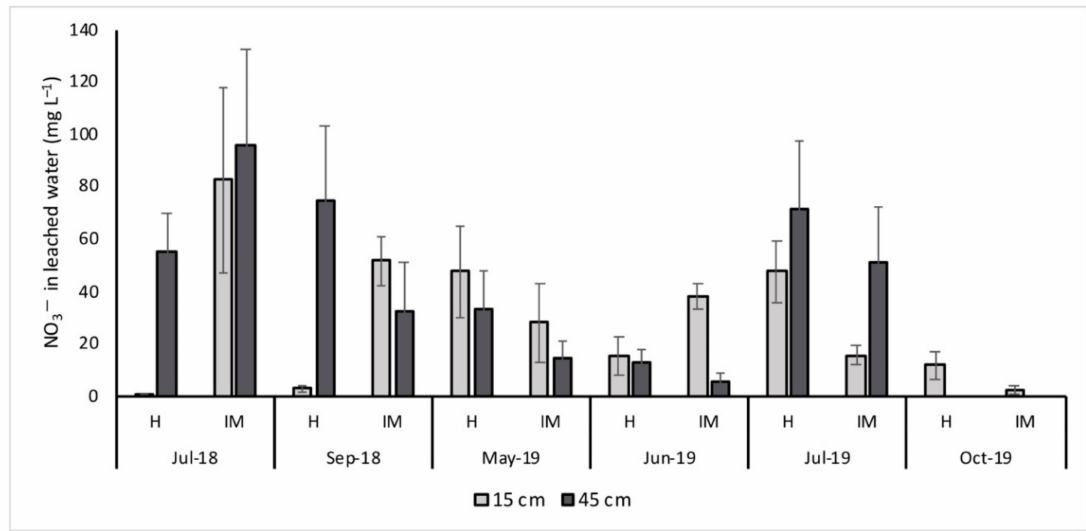
Figure 3. Treatment e ff ect (H = herbicide and IM = integrated mowing) on the concentration of NO 3 − of leached water, in both apple and peach orchards. Bars represent the standard